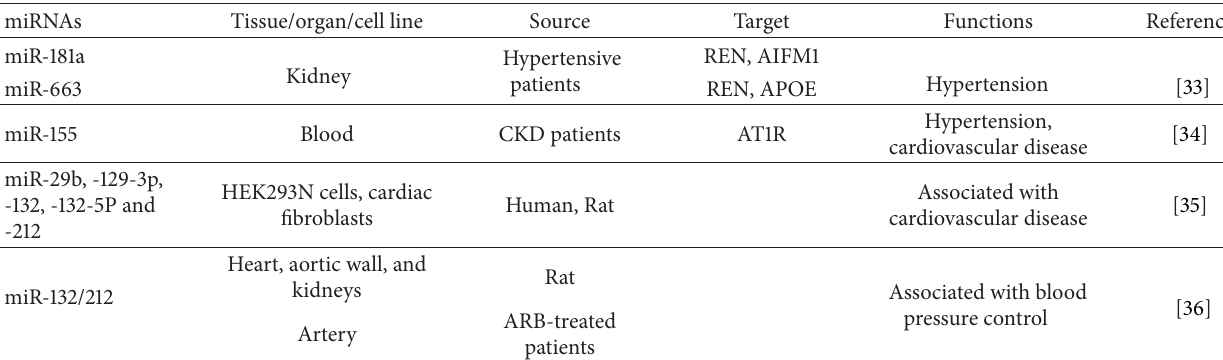
Table 1: Relevant miRNA in